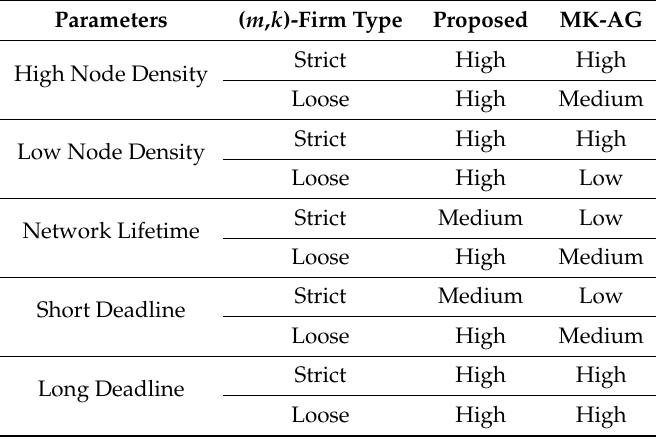
Figure 12. SDSR in (2,5)-firm application as a function of deadline. Table 2. Summary for